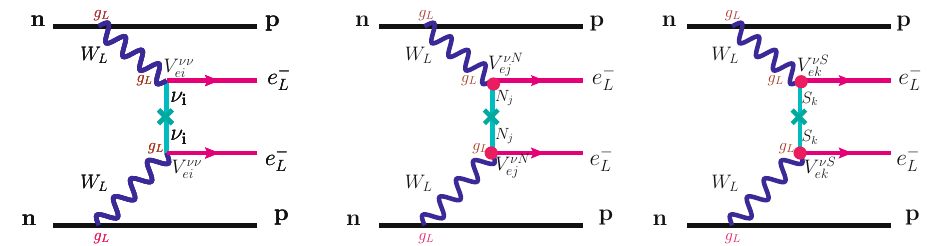
Fig. 6 Feynman diagrams for 0 ν ββ transition due to purely left-handed currents with the exchange of virtual Majorana neutrinos ν i , N j and S